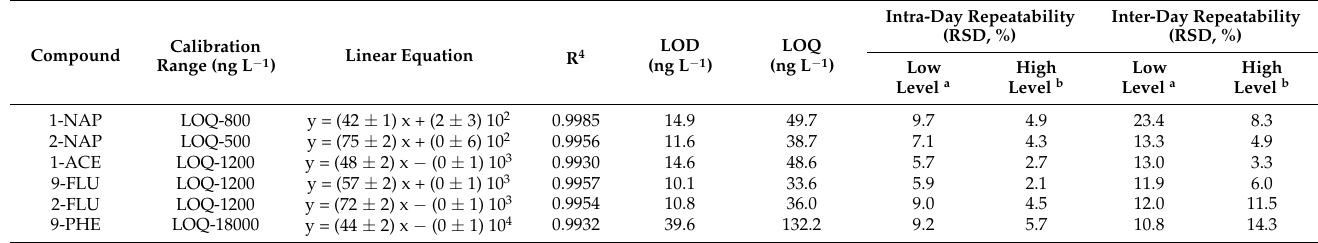
Table 3. Analytical characteristics of the proposed method for OH-PAHs in UHQ-water.